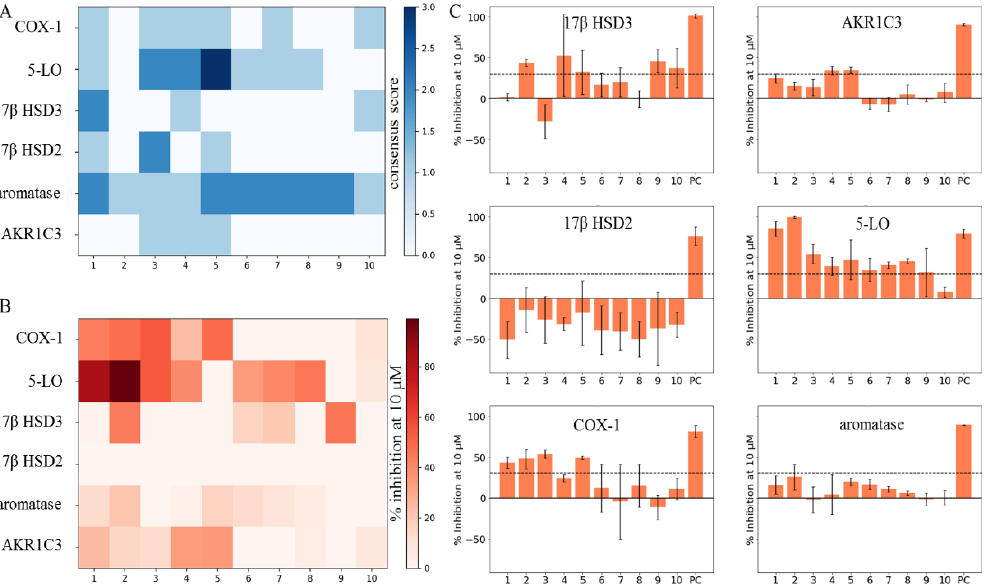
Figure 4. Comparison of an unknown DHC biological space (COX-1, 5-LO, 17β HSD3, 17β HSD2, aromatase, and AKR1C3) and actual in vitro test results of compounds 1 – 10 . ( A ) CSs of compounds 1 – 10 on all of the six targets of the unknown DHC biological space plotted as a heatmap. ( B ) Means ( n = 3) of the percent inhibition at 10 µM (0–100%) of compounds 1 – 10 on all of the six targets of the unknown DHC biological space plotted as a heatmap. Observations with mean inhibition values smaller than 30% or relative standard deviations greater than 20% were regarded as inactive. ( C ) Bar charts of the six targets of the unknown DHC biological space showing compounds 1 – 10 with the respective means ( n = 3) of the percent inhibition at 10 µM (0–100%) and the standard deviation. A cut-off of 30% inhibition at 10 µM was chosen (black dashed line), for separating the active from inactive observations. Dimethylsulfoxide (DMSO) was used to measure the baseline enzyme activities on which the samples were normalized (not shown), and positive controls (PC) were used as indicated in the Materials and Methods and in Supplementary Information S-5. Table 3. In vitro inhibitory activities of compounds 1 – 10 towards targets of the DHC biological space, expressed as percent inhibition (0–100%) at 10-µM compound concentration relative to the DMSO mock control. Shown is the mean of three independent experiments ( n = 3) plus/minus the standard deviation. Different compounds were used as positive controls (PC), as indicated in the Materials and Methods. Highly negative values of 17β HSD2 assays are believed to be technical artefacts, as enzyme activation seems unlikely.